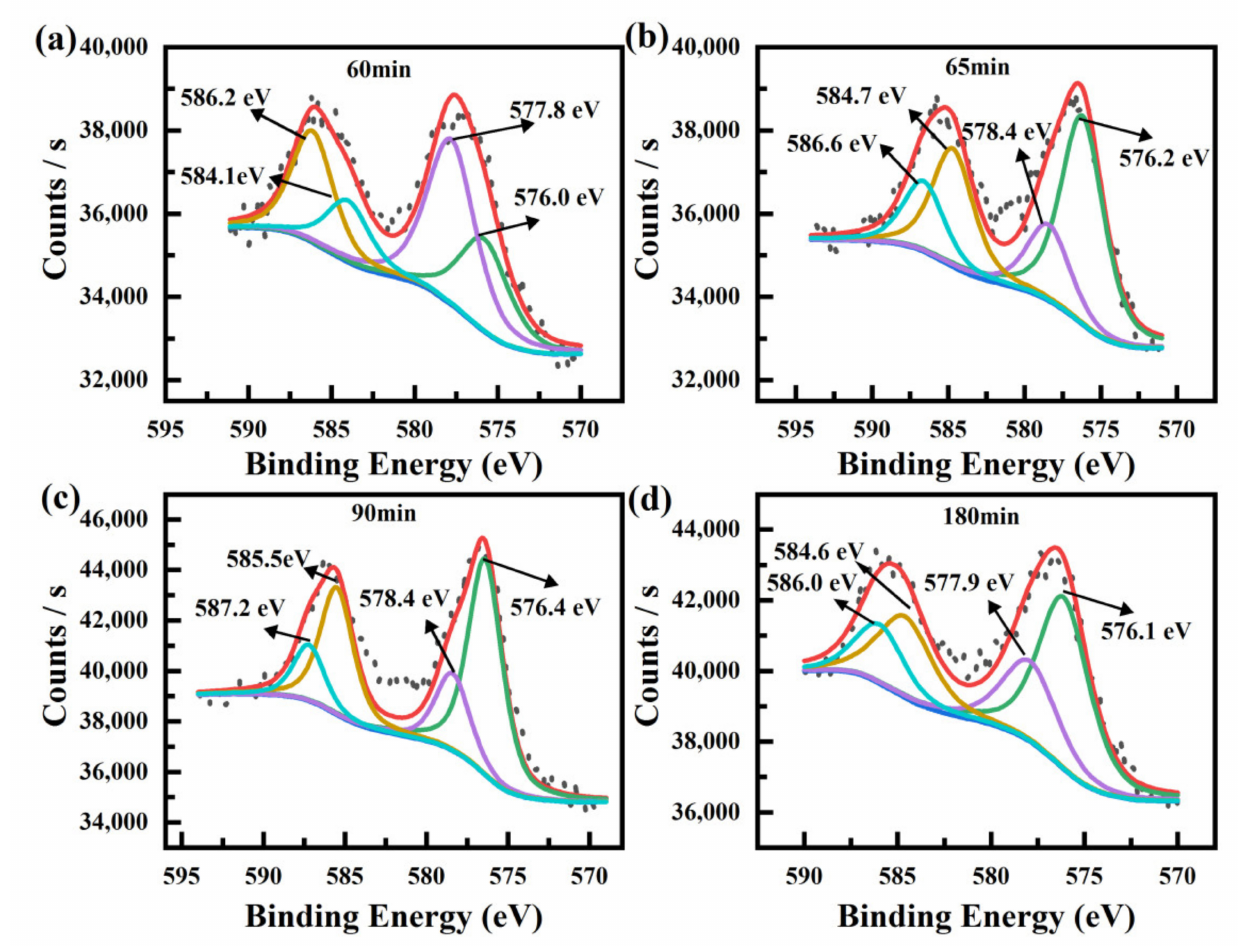
Figure 7. Core-level XPS of Cr for Z100T200 at different stages during the removal process. ( a ) 60 min. ( b ) 65 min. ( c ) 90 min. ( d ) 180